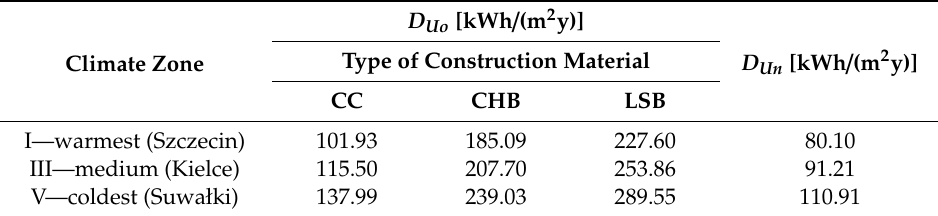
Table 2. Energy demand for heating the